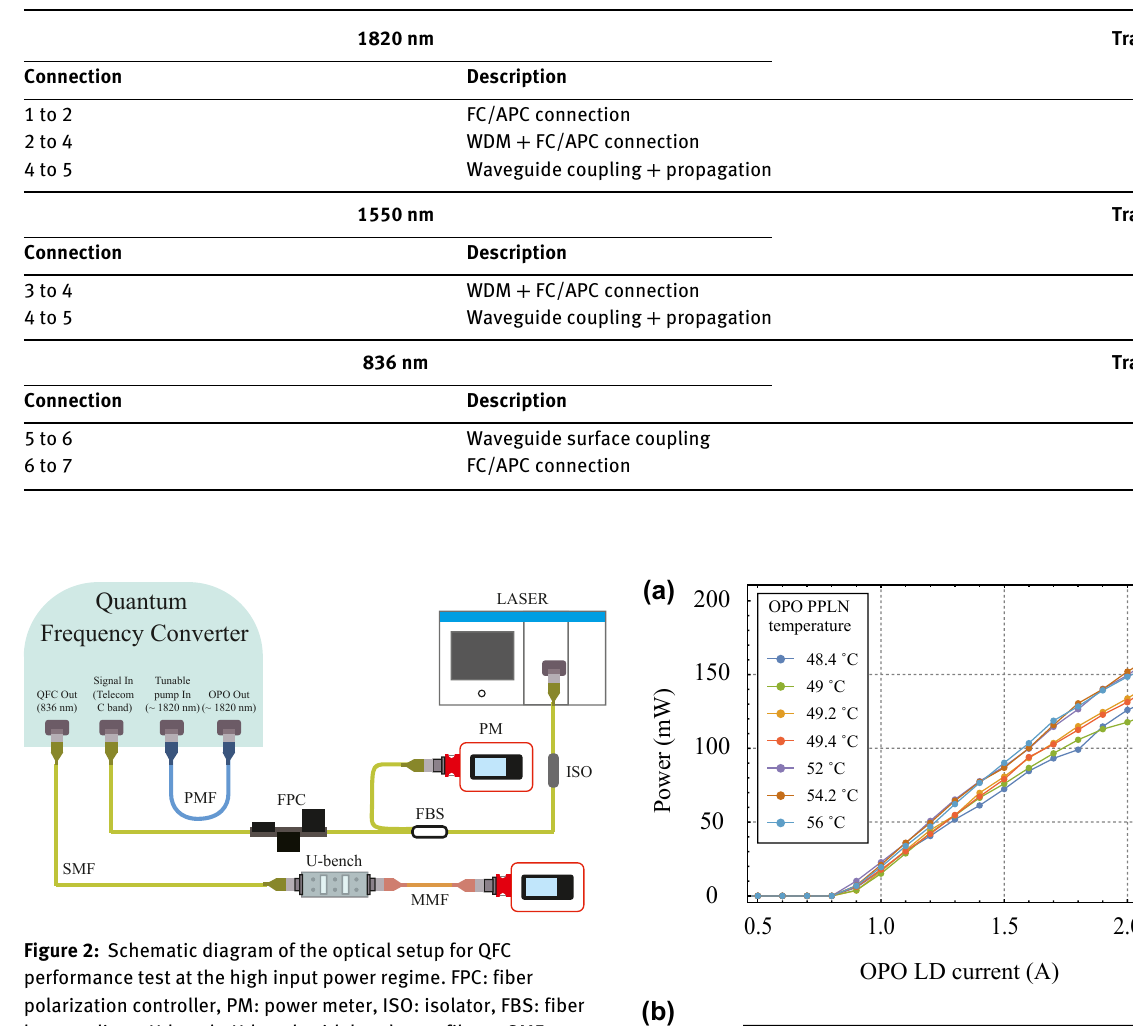
Table 1: Transmissions of the quantum frequency converter components. The connection information is shown in Figure 1.